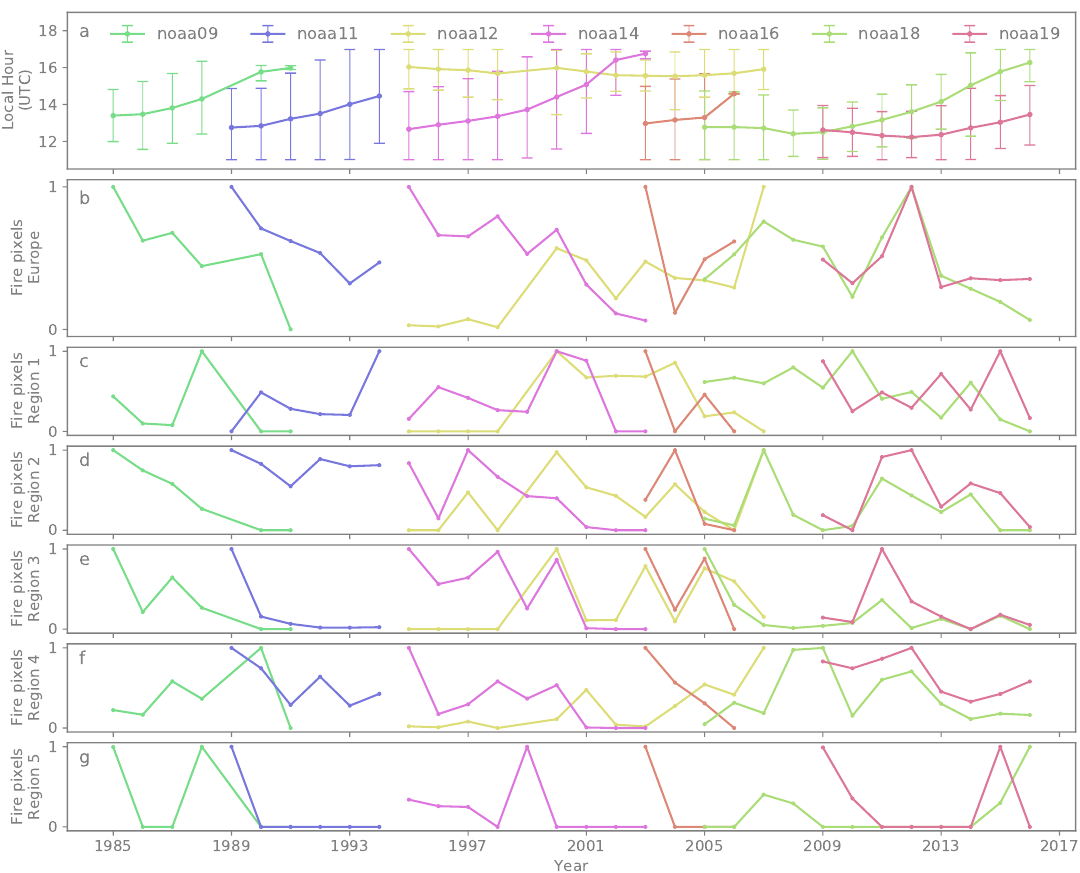
Figure 2. Annual mean local hour and relative number of mean yearly active fire pixels retrieved from the Advanced Very High Resolution Radiometer (AVHRR) active fire product (AVH18). The local hour refers to the overhead time of the National Oceanic and Atmospheric Administration (NOAA) satellites above Bern, Switzerland. Some satellites overpassed Europe twice at daytime ∼ 102min apart, which is indicated by the annual mean minimum and maximum overpass time ( a ). However, each of the regions were typically covered by only one of these overpasses. The relative number of mean yearly active fire pixels are shown for Europe ( b ) and relative to the maximum observed value for the regions 1 to 5 ( c – g ). Note, that very few fires were detected in region 5 and none of them by